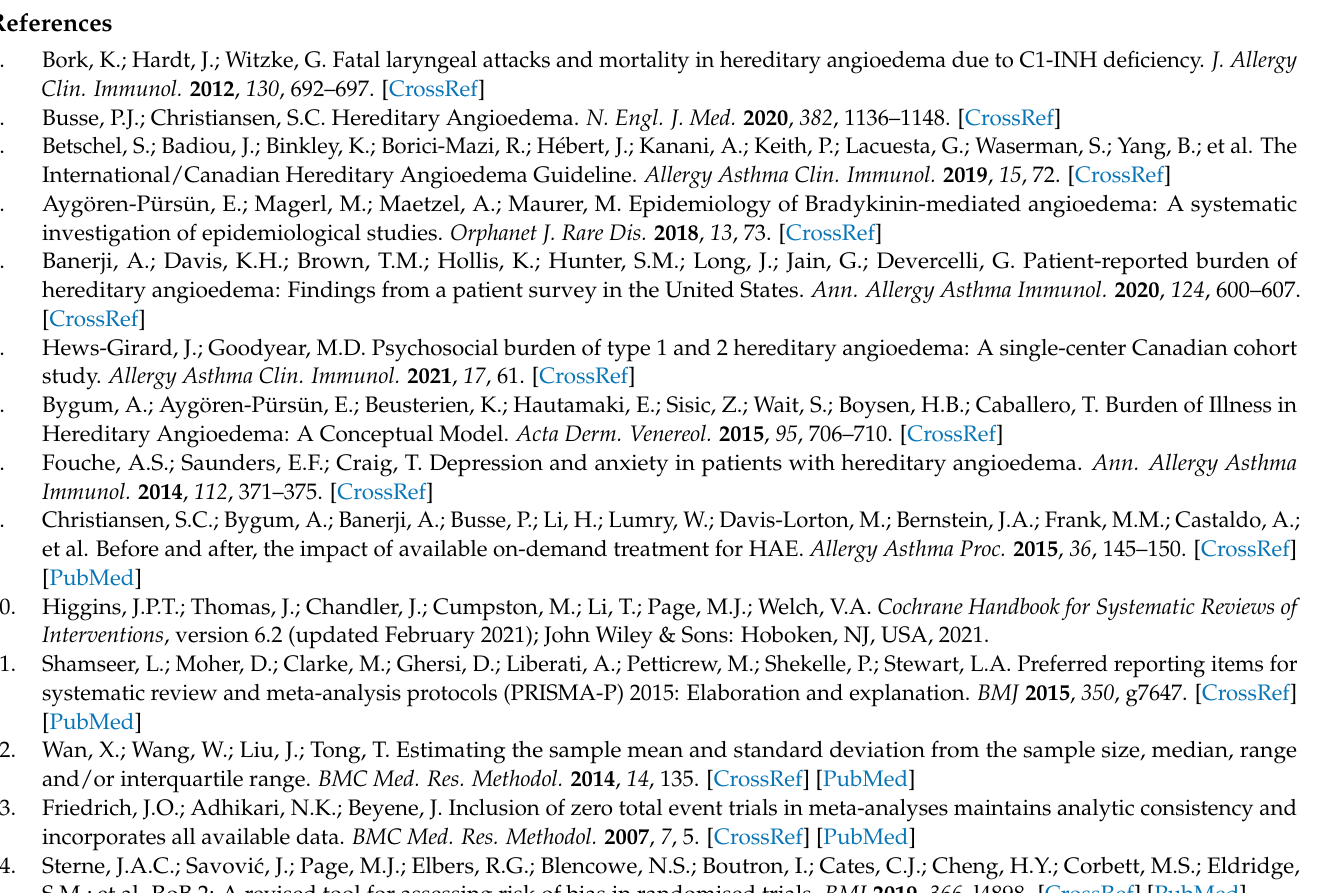
Table S2: Gray literature from ongoing clinical trial